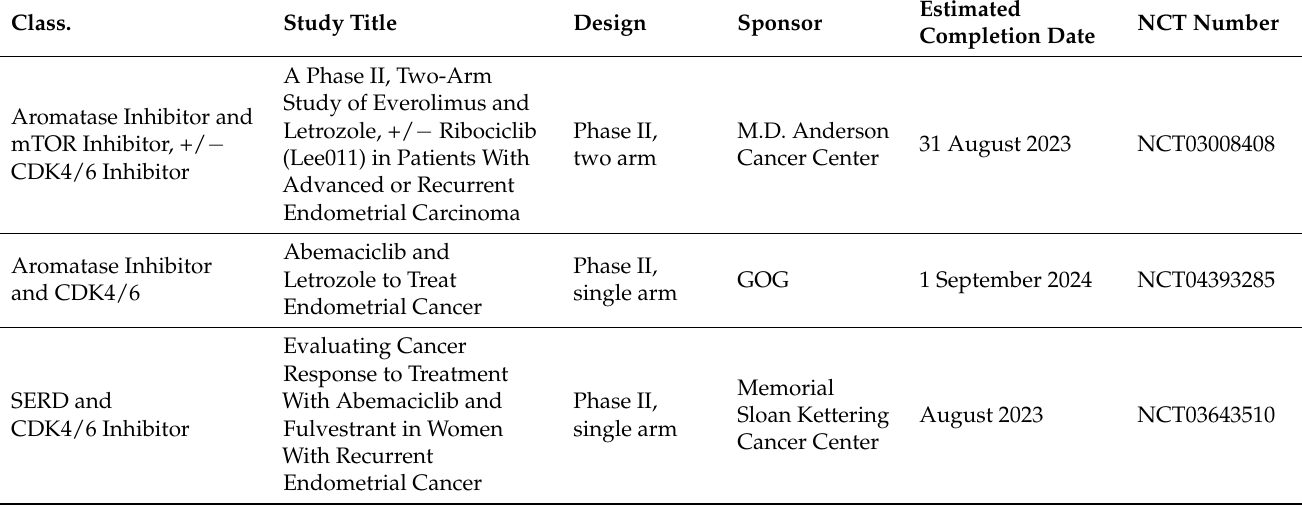
Table 3. Combination hormonal therapy with targeted therapy, ongoing clinical